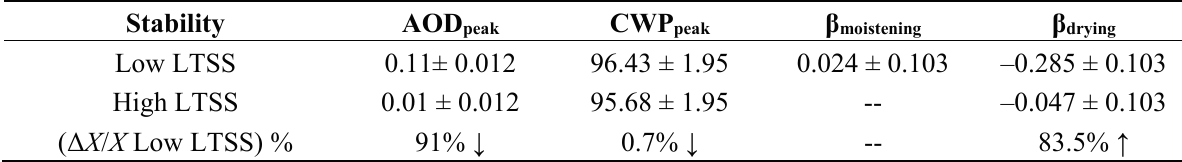
Figure 17. Response of cloud water path (CWP) to increasing aerosol optical depth (AOD) for low (unstable atmospheric condition) and high (stable atmospheric condition) lower tropospheric static stability (LTSS). Table 11. Percent of increase ( ↑ ) or decrease ( ↓ ) in the characteristics parameters of cloud water path response curve aerosol induced perturbation from low to high lower tropospheric static stability (LTSS) environment for